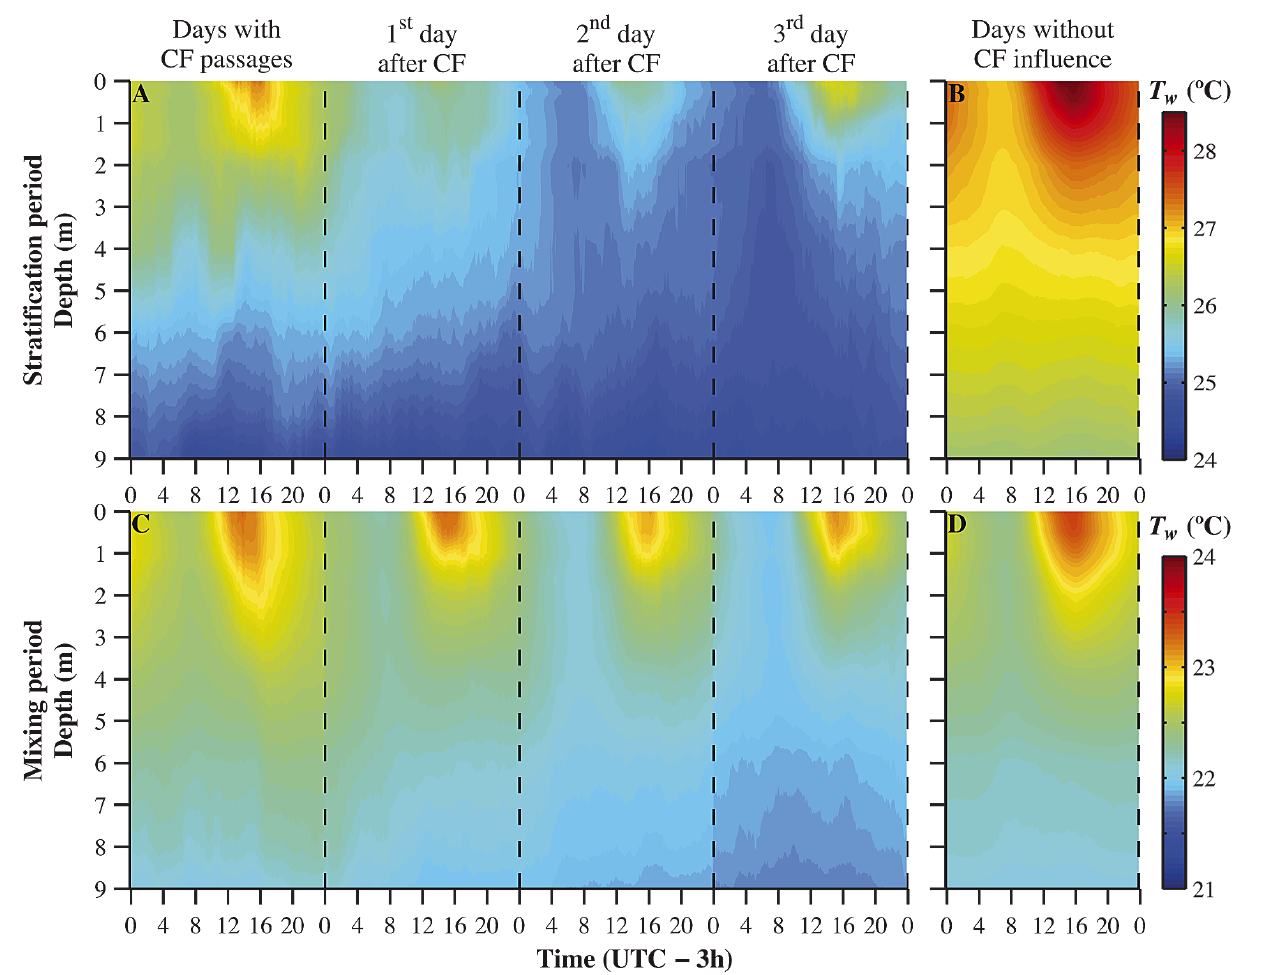
Fig. 7. Diel vertical distribution of water temperature ( T w ) upon (A,C) occurrence of cold front (CF) passages and 3 d after- wards, and (B,D) without CF influence, in periods of (A,B) stratification and (C,D)